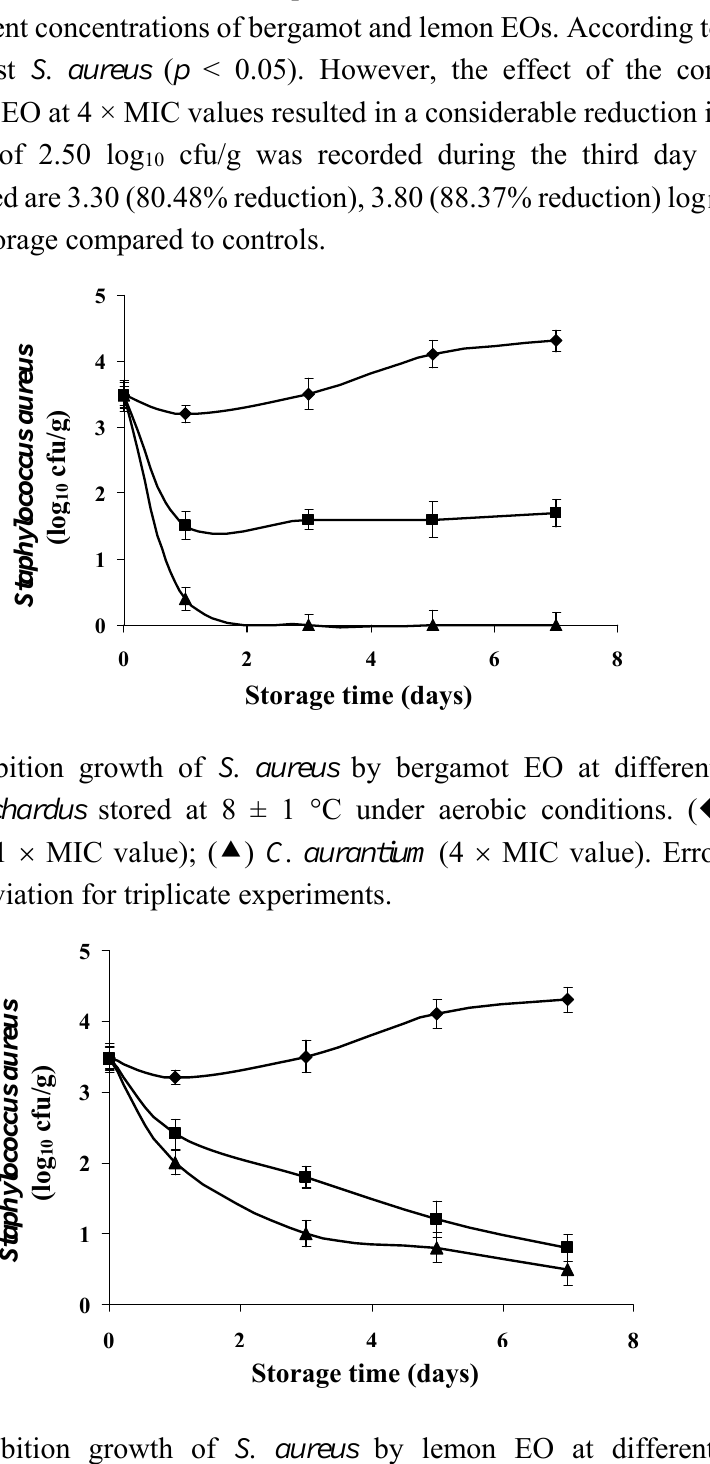
Figure 7. Inhibition growth of S . aureus by lemon EO at different concentrations in Sardina pilchardus stored at 8 ± 1 °C under aerobic conditions . (  ) Control; (  ) C . limonum (1 × MIC value); (  ) C . limonum (4 × MIC value). Error bar represents the standard deviation for triplicate